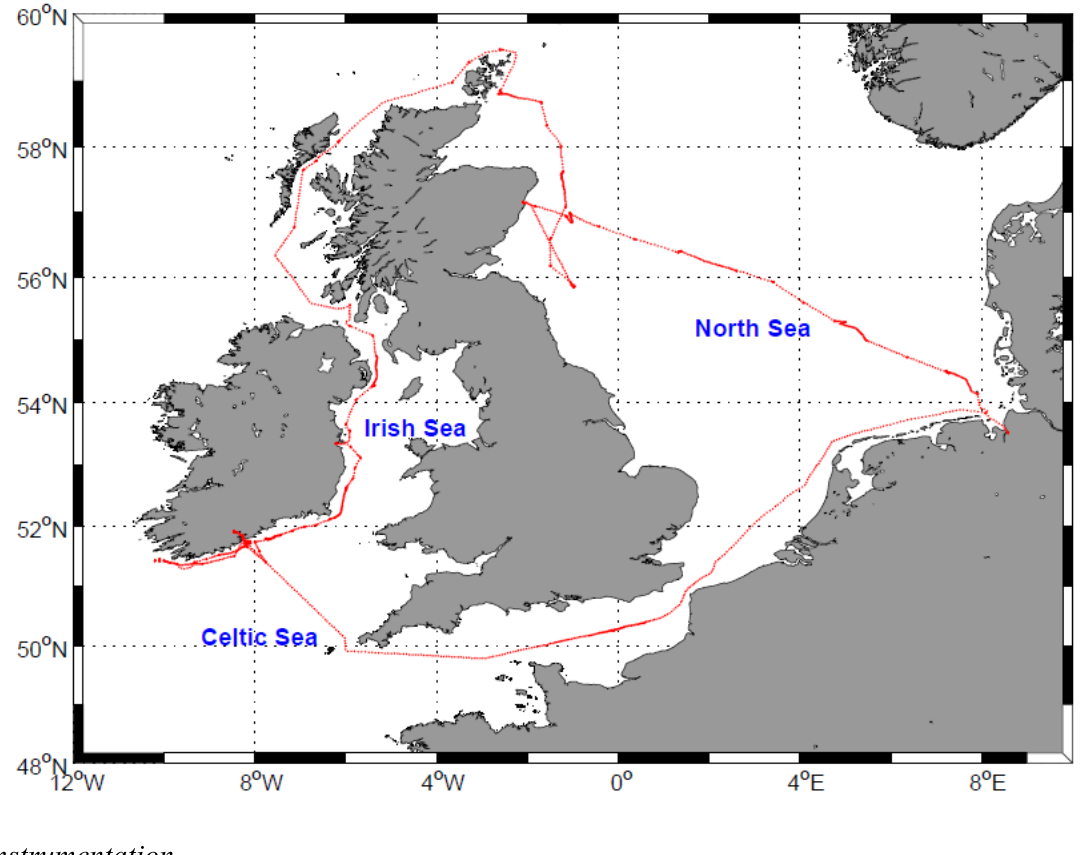
Figure 1. R/V Heincke HE302 cruise track (red line) where above-water hyperspectral optical measurements were taken between 21 April and 14 May